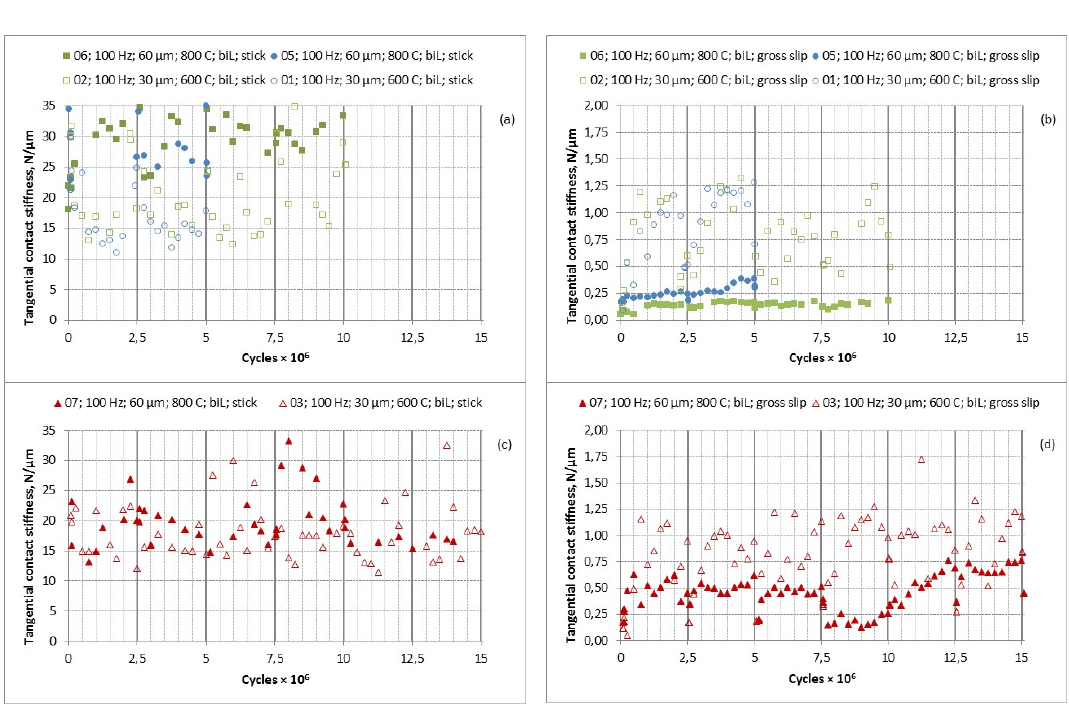
Figure 7. Contact stiffness: ( a ) pairs 01, 02, 05, 06 in stick condition; ( b ) pairs 01, 02, 05, 06 in gross slip condition; ( c ) pair 03, 07 in stick condition; ( d ) pair 03, 07 in gross slip condition.